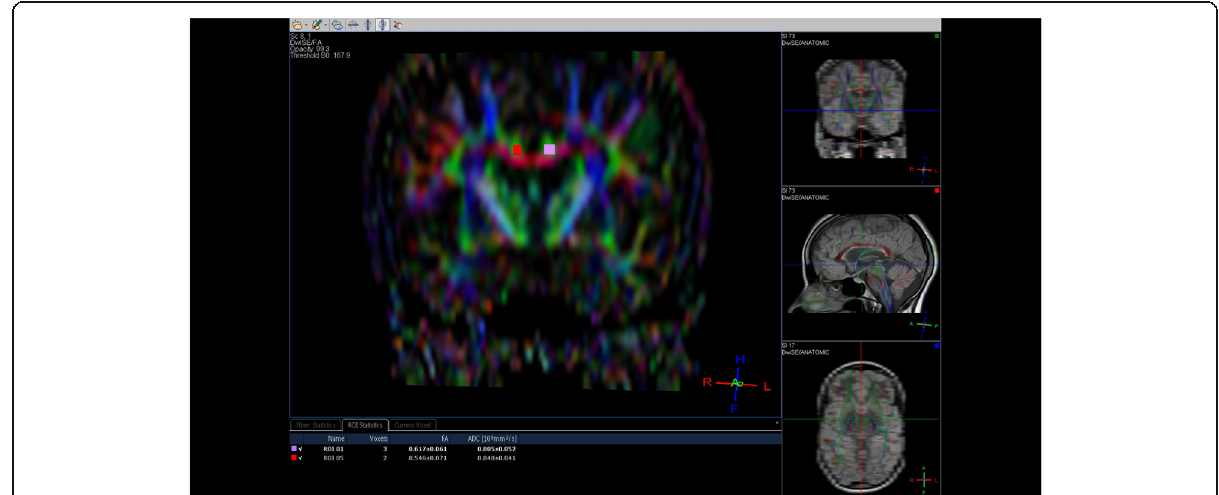
Fig. 1 32-year-old female patient known to have MS with recent onset of depressive symptoms (BDI 15). Colour-coded FA maps of the cingulum cingulate showing FA reduction of the right and left cingulum (FA 0.617± 0.061 on the right and 0.546 ± 0.071 on the